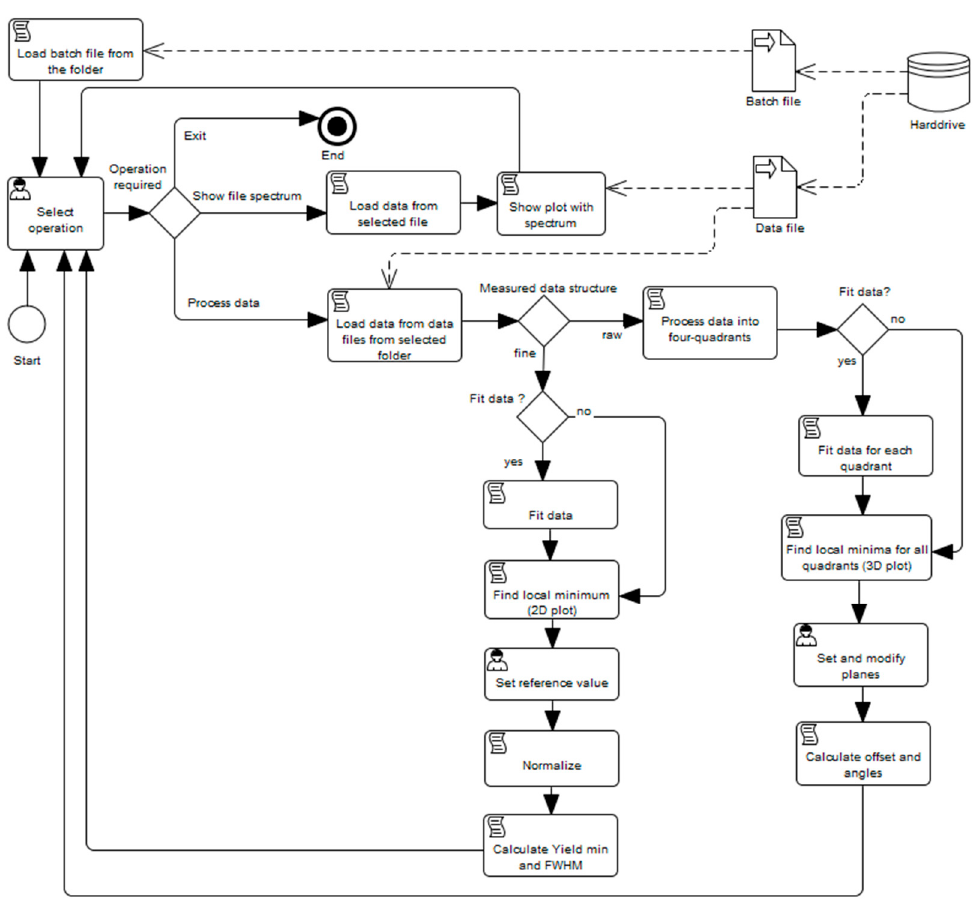
Figure 10. Designed Coarse and Fine RBS/C evaluation algorithm.